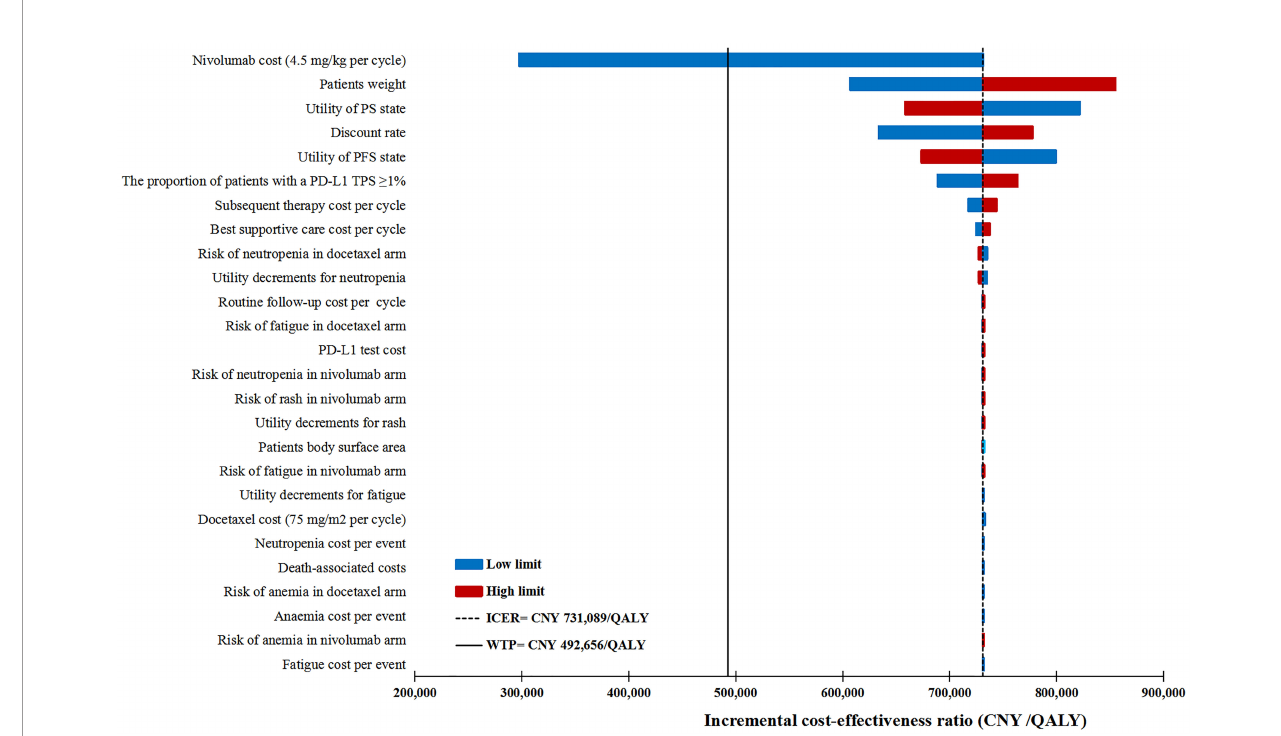
FIGURE 3 | The result of one-way deterministic sensitivity analysis for the PD-L1 test-based strategy (C) versus docetaxel (A). ICER, incremental cost-effectiveness ratio; WTP, willingness-to-pay; QALY, quality-adjusted life-year; PFS, progression-free survival; PS, progressed survival; PD-L1, programmed death ligand 1; TPS, tumor proportion